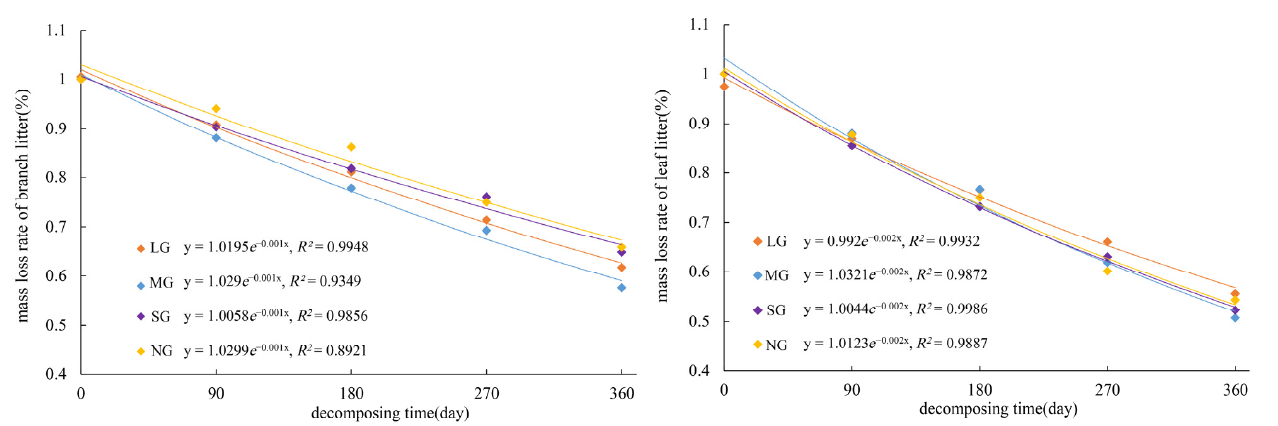
Figure 1. Fitting model of litter decomposition index in canopy gaps and non-gaps. Figure 1. Fi tt ing model of li tt er decomposition index in canopy gaps and non-gaps. Table 2. Regression equation of li tt er mass remaining during li tt er decomposition.